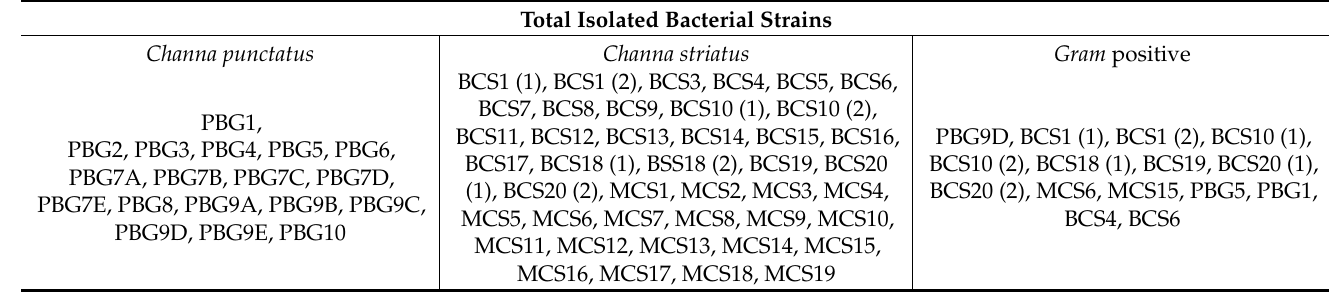
Table 1. Total bacterial strains isolated from Channa punctatus and Channa striatus . Total Isolated Bacterial Strains